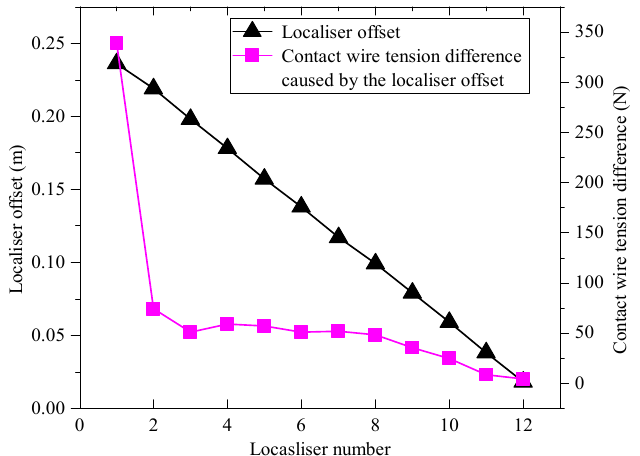
Figure 10. Localizer offset values of the 1st–13th spans and the contact wire tension difference. When the contact wire mid-point anchor was located at the 14th span, the total contact wire tension difference along the direction of the line caused by the localizer offset of the 1st–13th spans was 801.900 N (calculated with Formula (24)). The downslope component caused by the contact wire’s gravity of the 1st–13th spans was 193.356 N, which was calculated with Formula (25). Similarly, the offset values of the 13 localizers of the 15–28th spans with the changing temperature and the contact wire tension difference resulting from the localizer deviation in the direction of the line were obtained, as shown in Figure 11. For the same reason, the 27# localizer had a significantly larger contact wire tension difference than the other localizers.